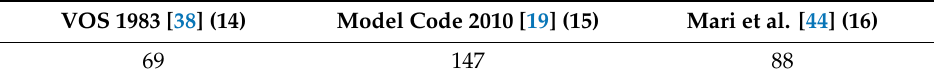
Table 6. Material properties of fracture energy [N /